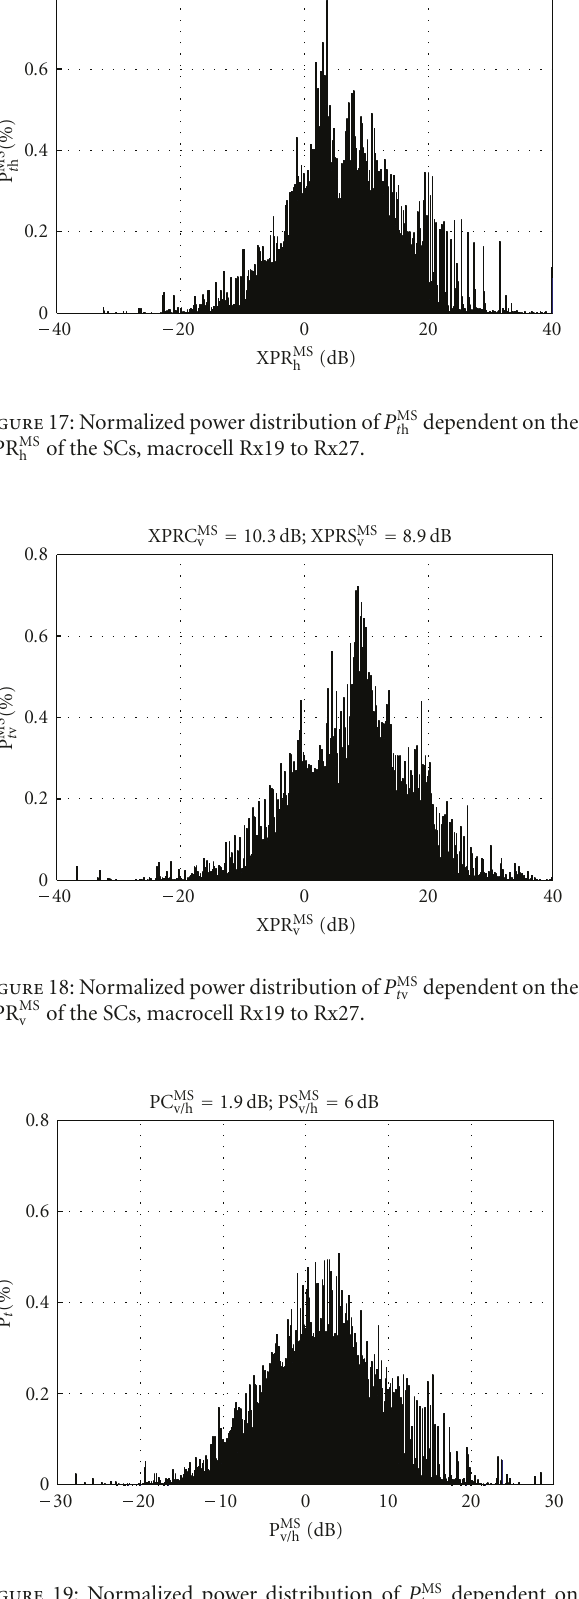
Figure 19: Normalized power distribution of P MS of the SCs, macrocell Rx19 to Rx27. P MS v/h